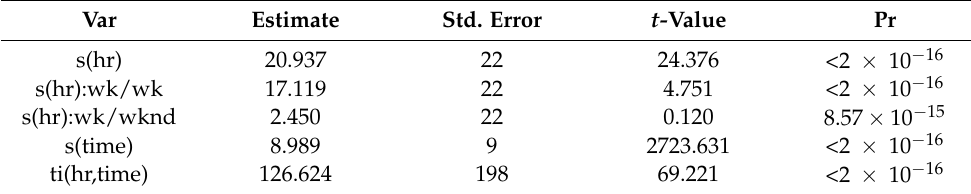
Table 10. Smooth terms/non-parametric coefficients extended non-spatial GAM with a spatial